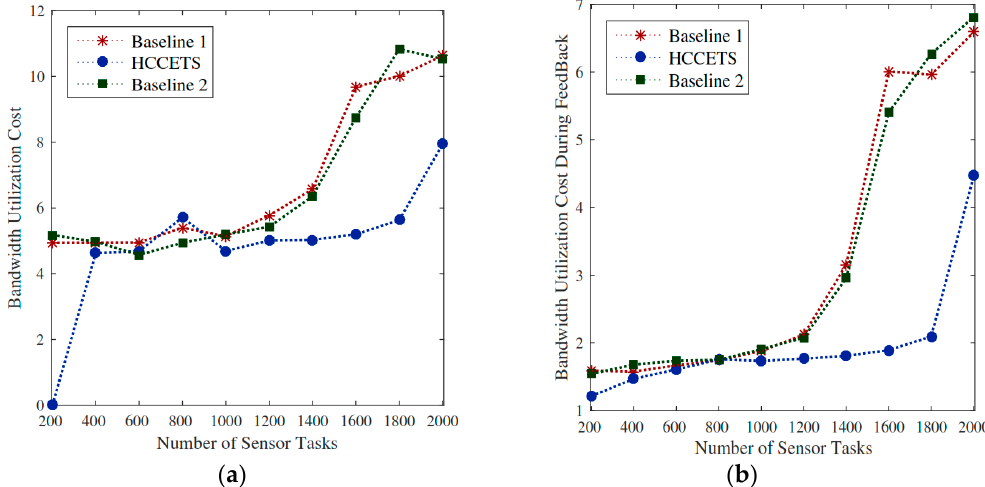
Figure 8. Utilization cost of fog servers. ( a , b ) shows that the relative percentage deviation of the HCCETS incurs lower utilization of metric bandwidth.